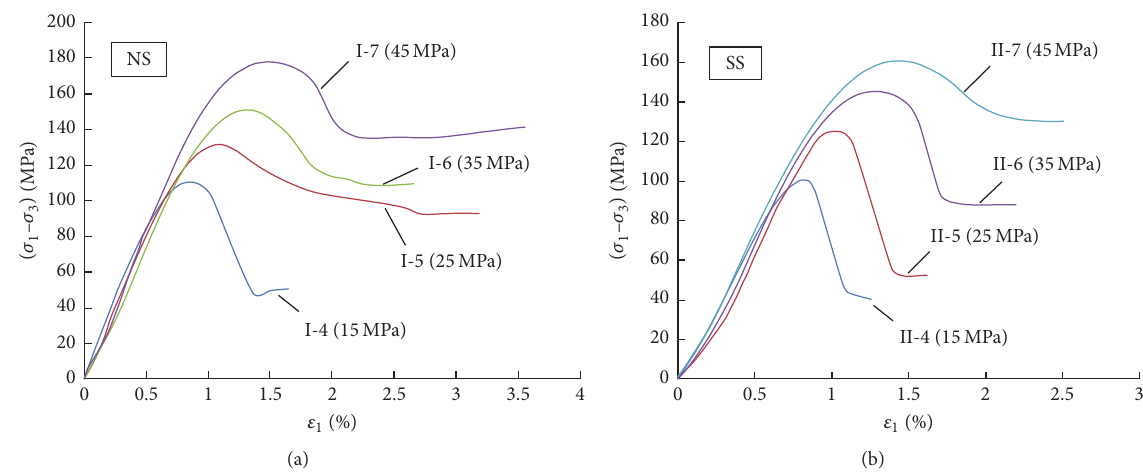
Figure 7: The stress-strain curves of triaxial compression tests under natural and saturated states.